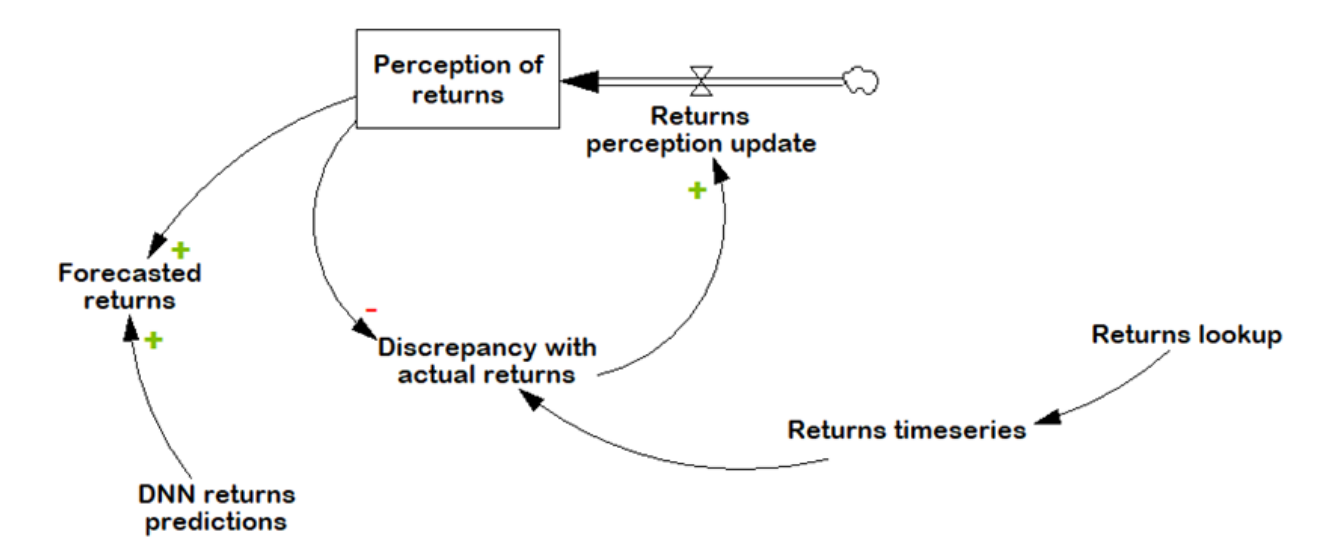
Figure 6. The partial system dynamics model for predicting returns.